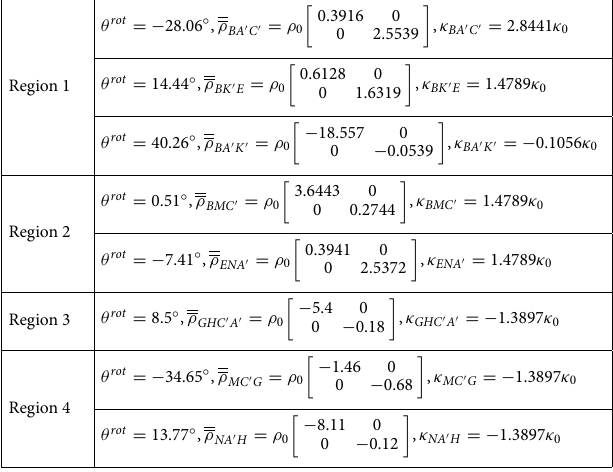
Table 2. The constitutive materials of the NCAC’s regions after